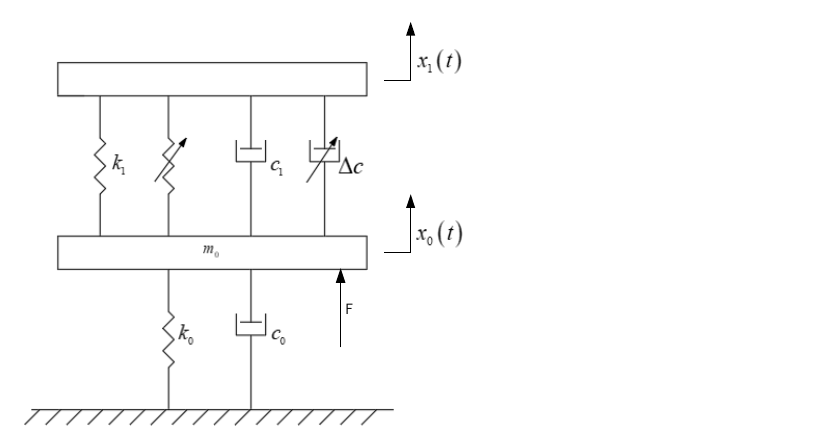
Figure 12. Dynamical model of the MRE vibration isolation system.